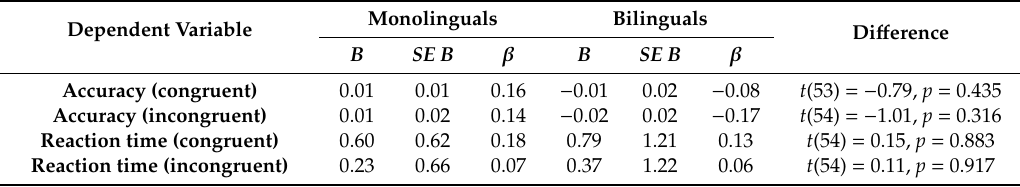
Table A4. Regression coe ffi cients and t -statistics of the relationship between rumination and the dependent variables (Simon